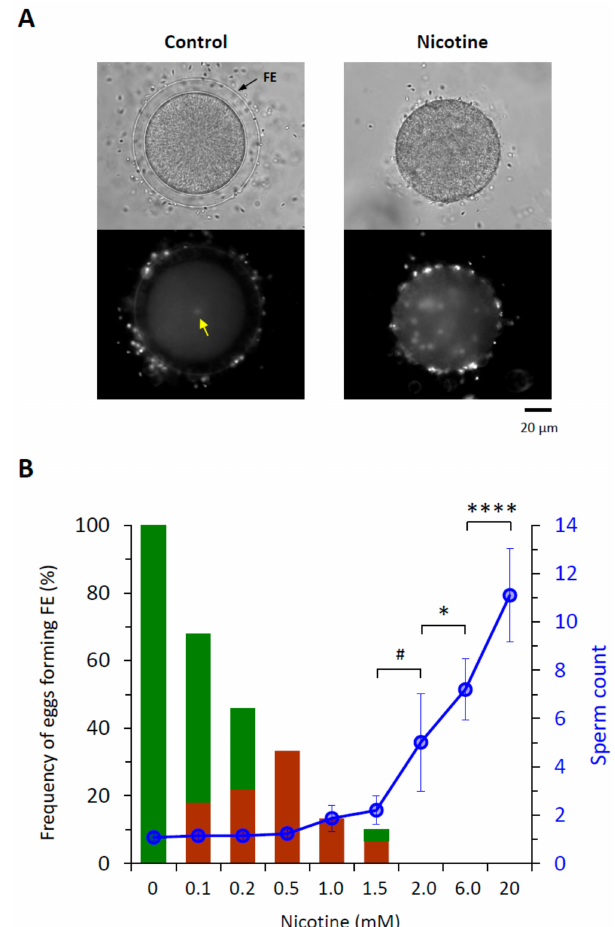
Figure 1. Nicotine induces polyspermy in a dose-dependent manner. P. lividus eggs were incubated for 5 min in the presence of various concentration of nicotine. About 10 min after fertilization with Hoechst 33342-prestained sperm, the zygotes were examined with a CCD camera to monitor sperm entry and the elevation of the fertilization envelope (FE). ( A ) Bright field view and the epifluorescence photomicrographs (bottom) showing the control egg and the egg exposed to 6 mM nicotine prior to fertilization. Whereas a single sperm entered the control egg (yellow arrow), numerous sperm were incorporated into the nicotine-exposed eggs. ( B ) Quantification of the egg-incorporated sperm and the extent of FE elevation. Green bars in the histogram represent the eggs with full-fledged elevation of FE, while brown bars stand for the eggs showing thin modest elevation of the FE. Error bars indicate standard deviation of the sperm counts averaged from multiple eggs specified in Table 1. U-test: # P < 0.05, * P < 0.01, **** P <